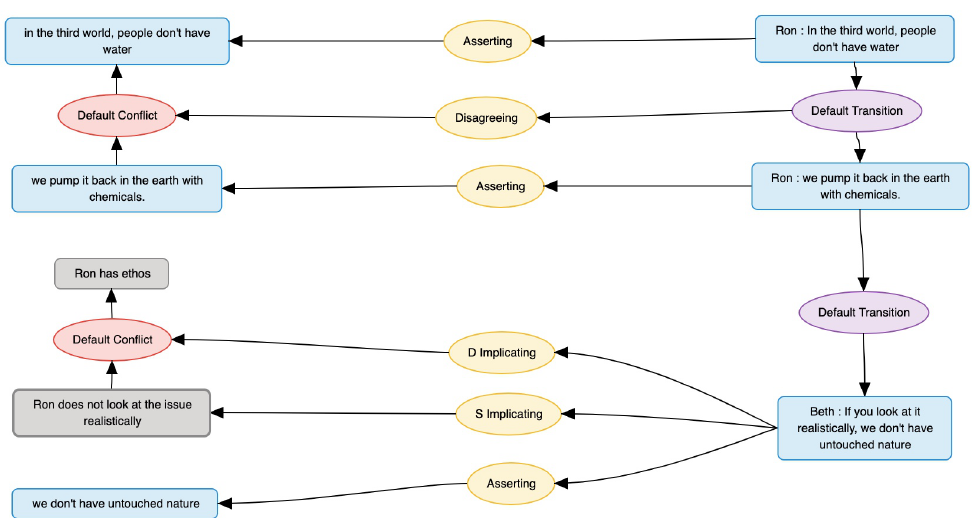
Figure 7. IAT CI structure for the implicated ethos attack in